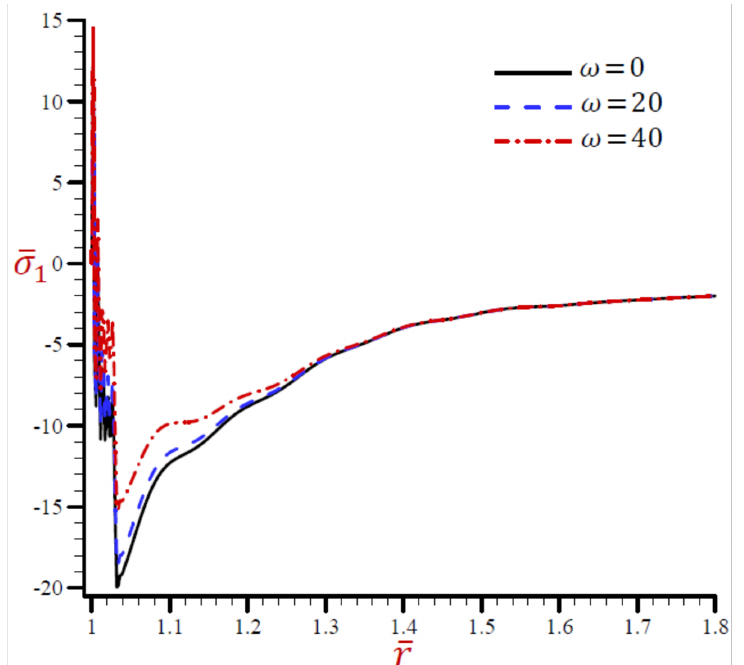
Figure 10. Effect of ω on radial stress σ 1 across the radial direction of the cylindrical cavity utilizing the RDPL model.